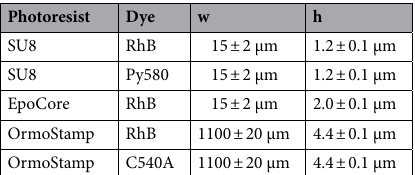
Table 2. Dye doped waveguide